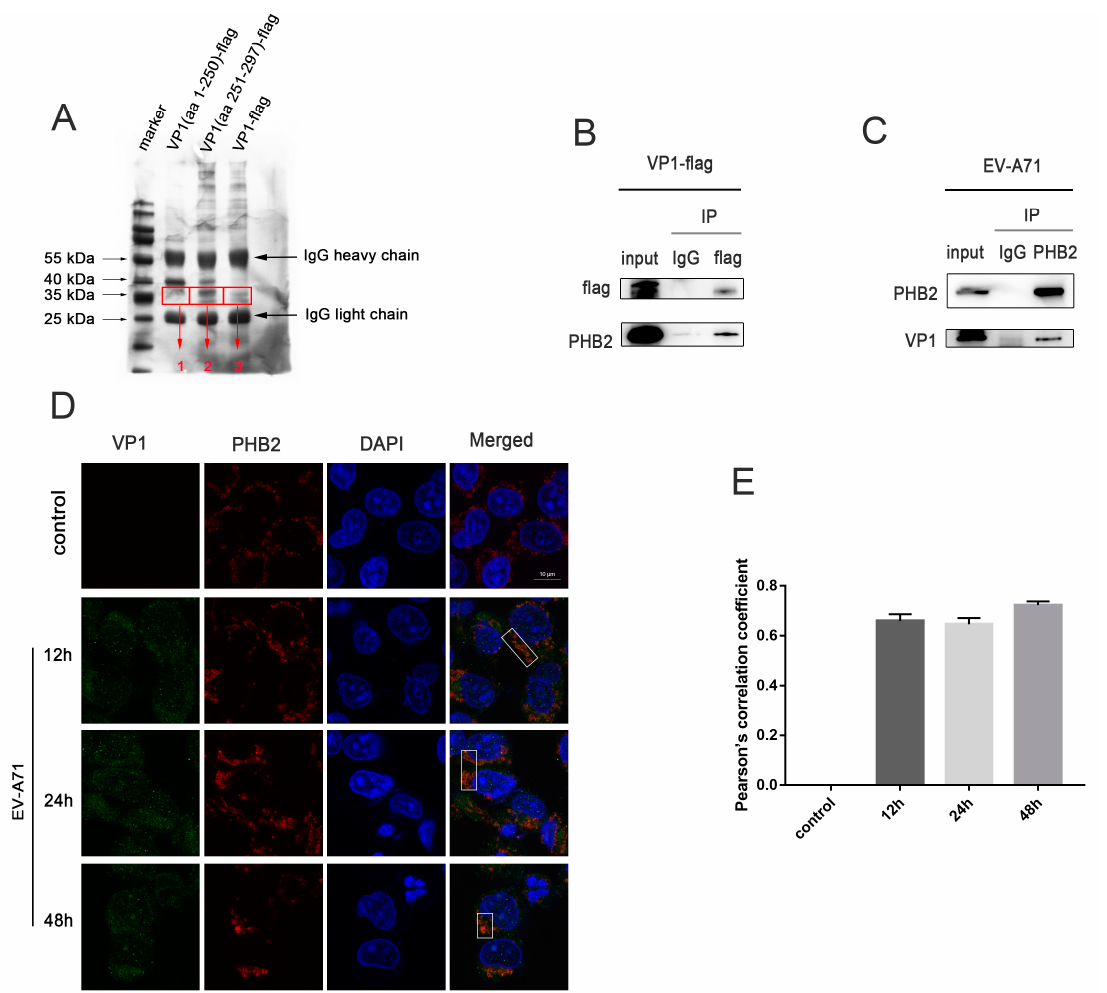
Figure 2. The EV-A71 VP1 protein interacts with PHB2. ( A ) HEK293T cells were transfected with VP1 (aa 1–250)-flag, VP1 (aa 251–297)-flag, and VP1-flag, and cell lysates were subjected to a co-IP assay with an anti-flag antibody. The coimmunoprecipitated proteins were separated by SDS-PAGE and visualized by silver staining. Three different gel bands were sent for mass spectrometry identification after tryptic in-gel digestion. The lists of proteins contained in band 1, 2, and 3 of Figure 2A correspond to Table S3, Table S4, and Table S5, respectively. ( B ) VP1-flag was transfected into